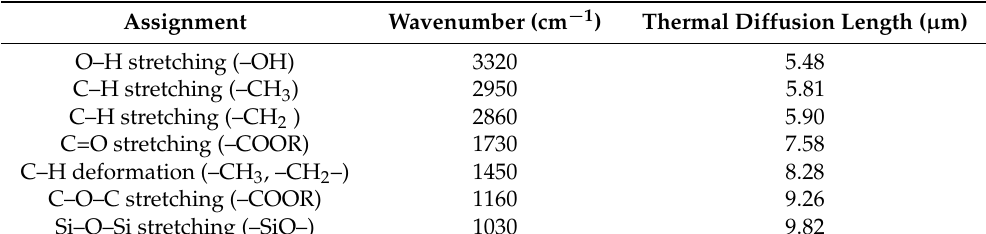
Table 1. Assignments of main absorbance bands at different thermal diffusion depth.